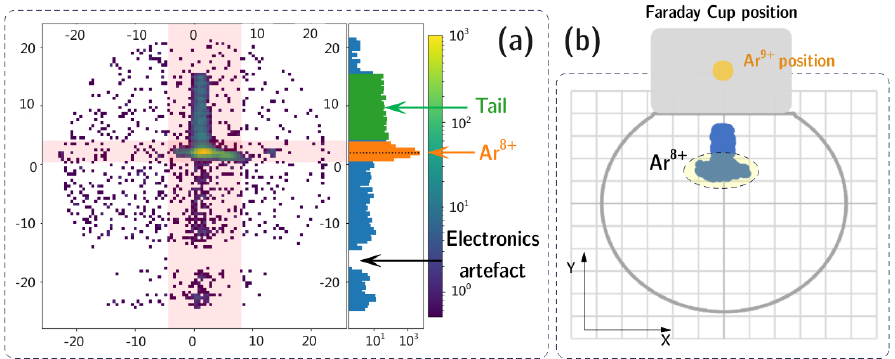
Figure 2. A recorded MCP image with the use of Ar 9 + as the primary beam exhibits the Ar 8 + peak and its tail ( a ). Results of SIMION simulations carried out with the same voltages and beam parameters ( b ). The horizontal line where no detection occur has been found to be an electronic artefact of the MCP.